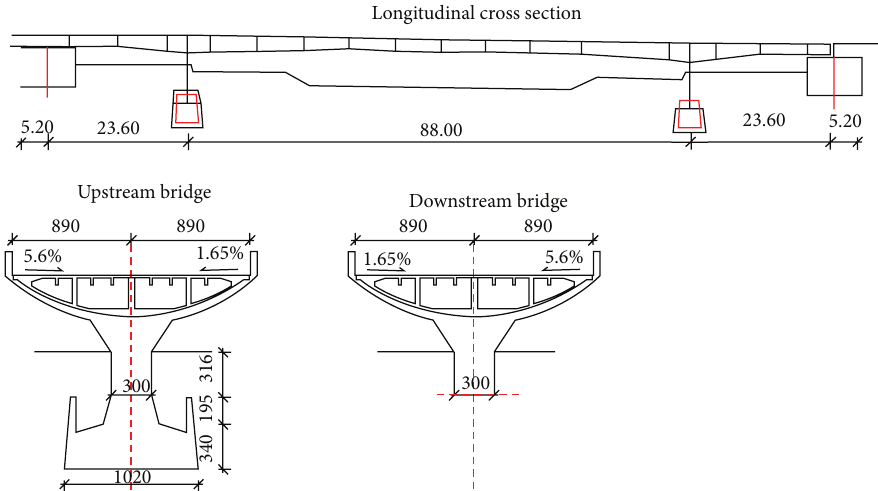
Figure 16: The twin bridge “Goce Delcev,” across rivers Vardar, Skopje, and Macedonia, elevation, and cross section of the